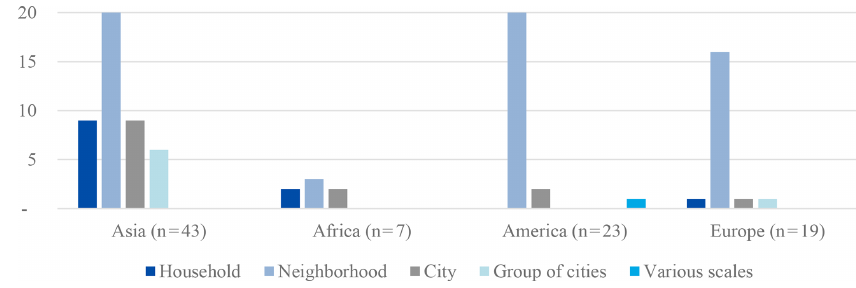
Figure 3. Classification of papers of flood vulnerability in terms of scale by continents.